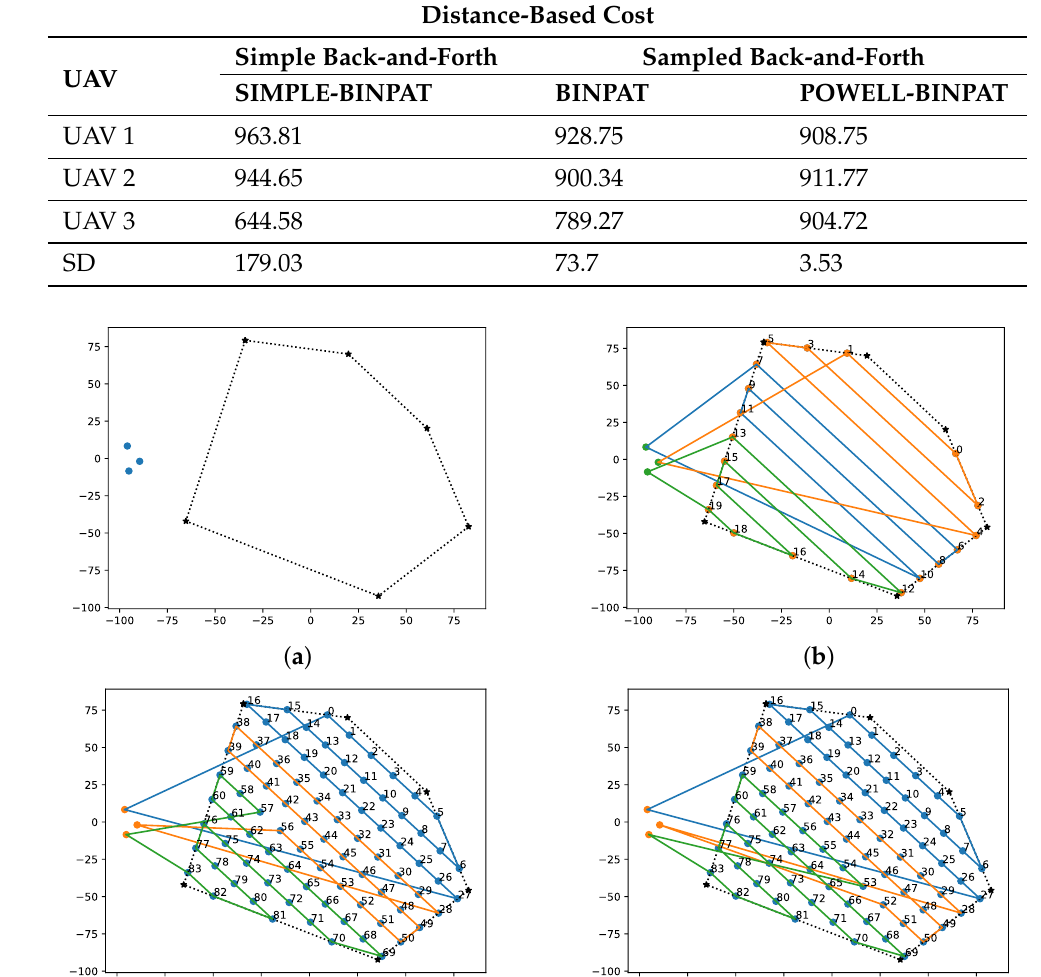
Table 2. Distance-based cost results using the BINPAT and POWELL-BINPAT for simple and sampled area decomposition.